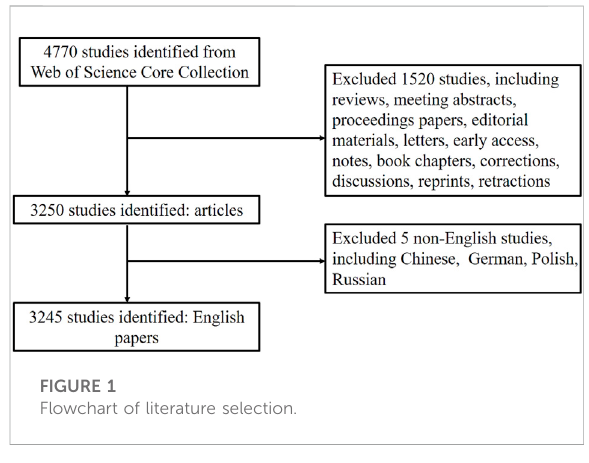
FIGURE 1 Flowchart of literature selection.